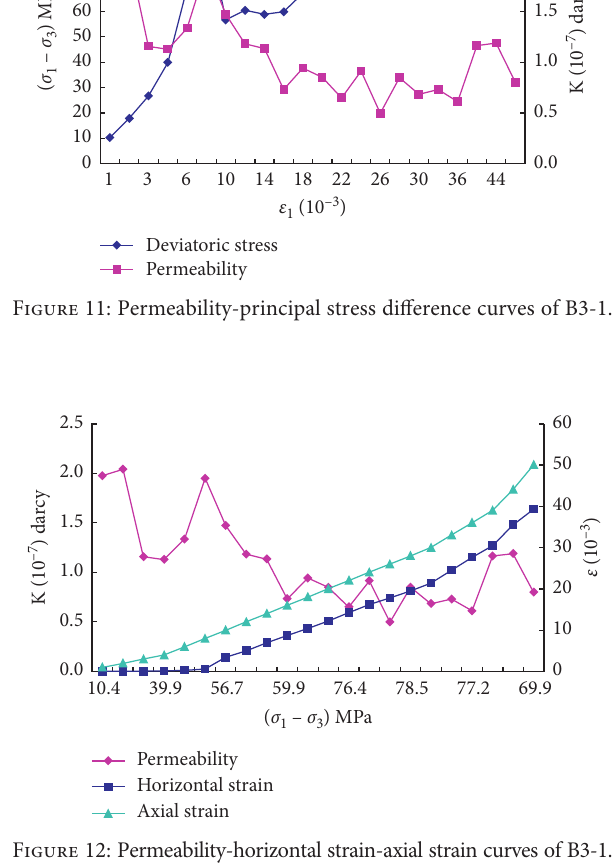
Figure 9: Permeability-principal stress difference curves of A3-2.